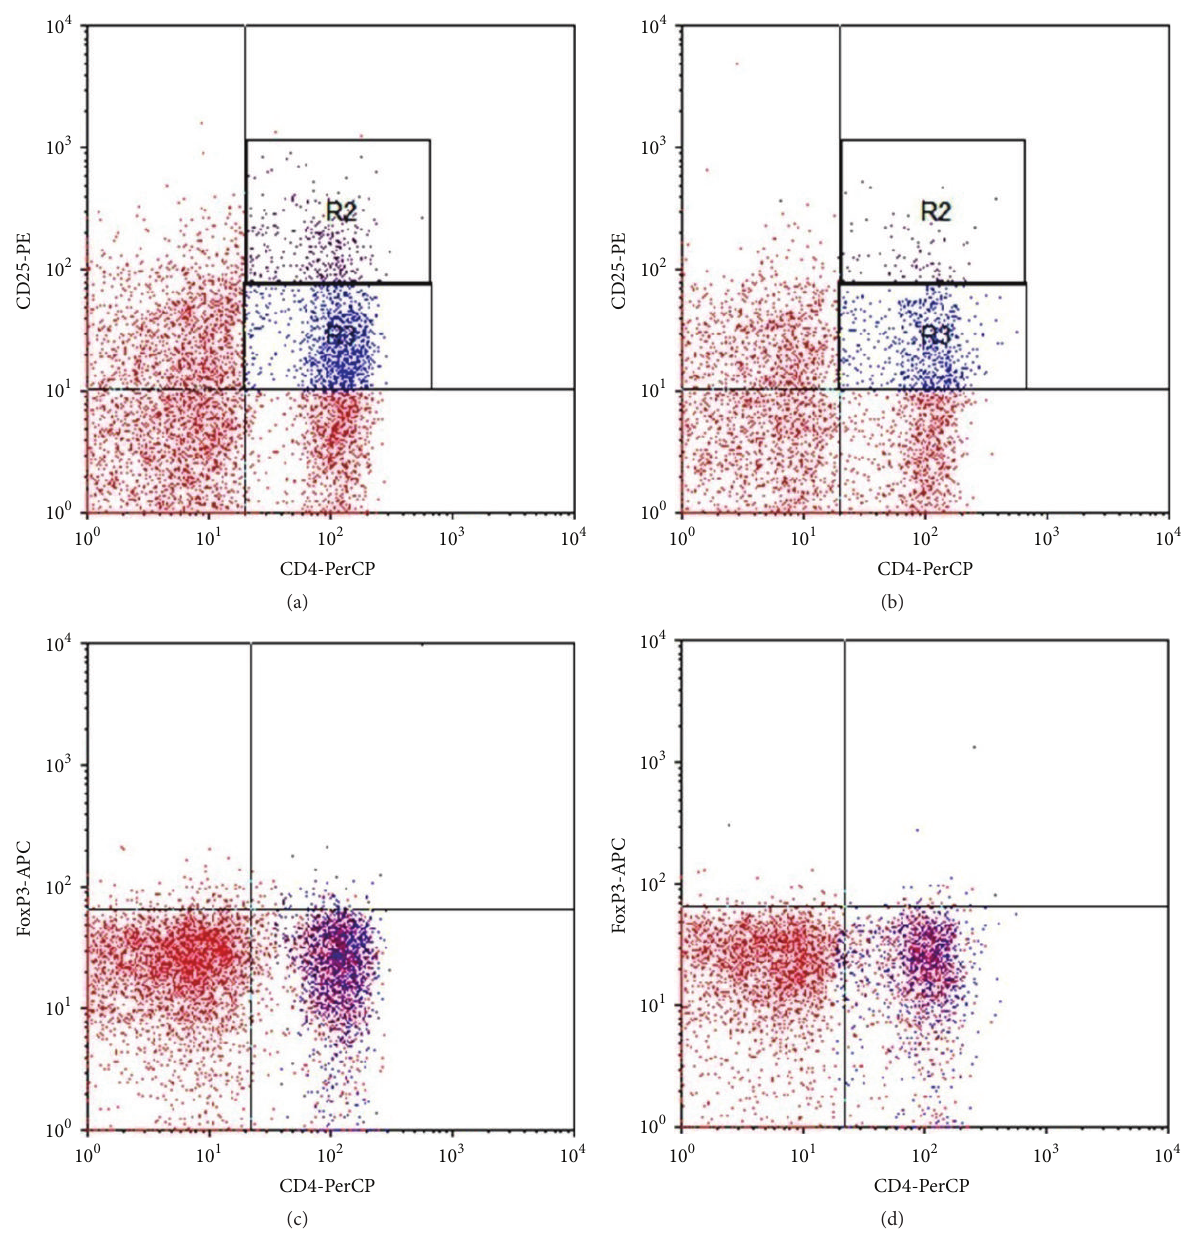
Figure 1: Frequency of circulating CD4 + CD25 + Tregs and CD4 + FoxP3 + T cells in healthy subjects and nonsegmental vitiligo patients by flow cytometry dot plot. (a) and (b) Representative profiles demonstrating Tregs as the CD4 + CD 25 high (R2) and CD4 + CD 25 low (R3) T-cell fraction by FACS analysis ((a) in a healthy subject, (b) in a vitiligo patient). (c) and (d) Representative profiles demonstrating Tregs as FoxP3 + CD4 T cells ((c) in a healthy subject, (d) in a vitiligo